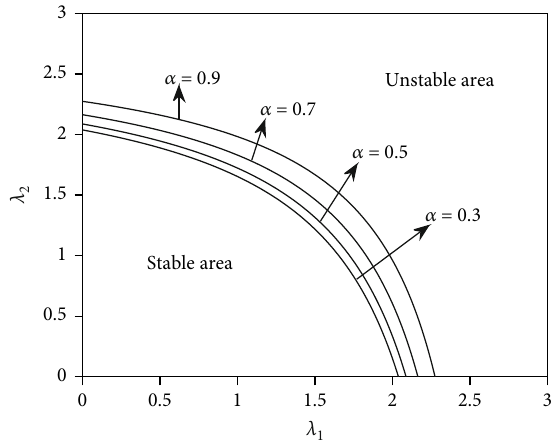
Figure 9: Stable area of ð λ